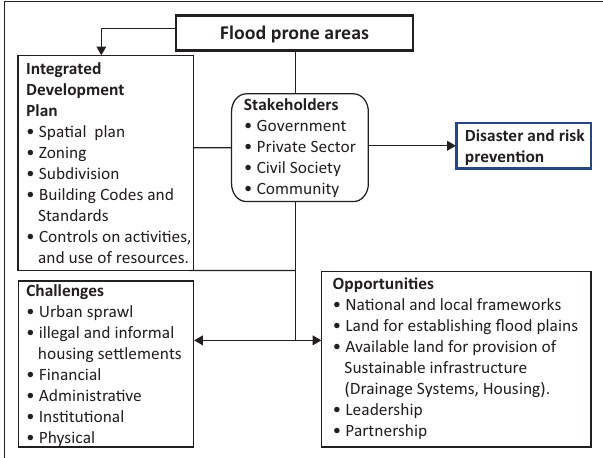
FIGURE 1: Conceptual framework of the